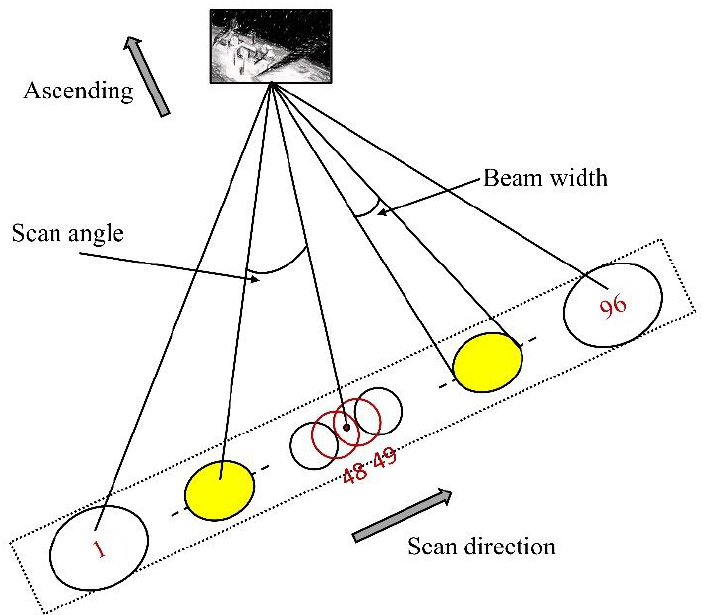
where T b represents the brightness temperature observed by FOV.